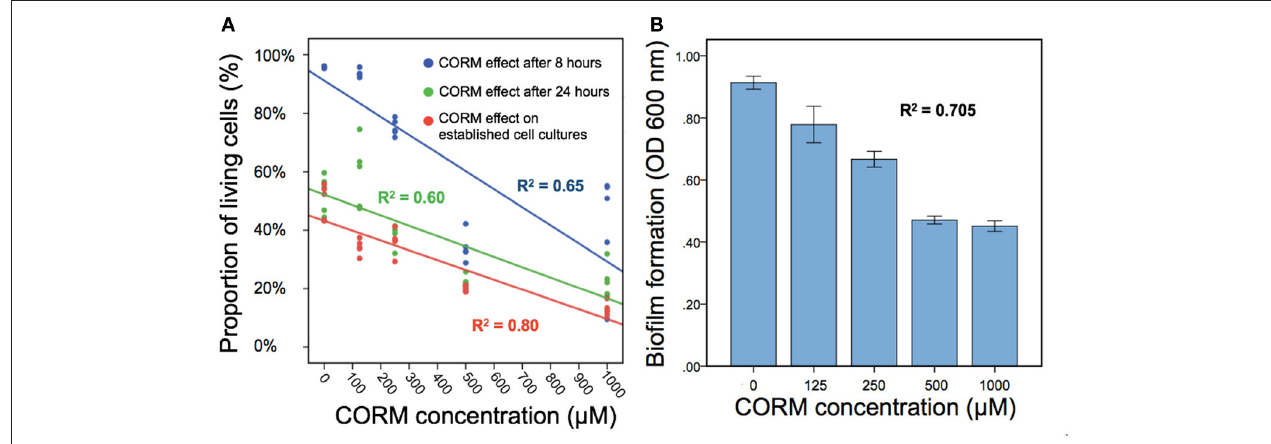
FIGURE 2 | The EBOR-CORM-1 effects on planktonic and biofilm cells of P. aeruginosa PAO1. In (A) , different lines denote for cell densities after 8h (blue line) and 24h (green line) of EBOR-CORM-1 application and EBOR-CORM-1 effects on established cell cultures (red line) in different CORM concentrations. (B) shows